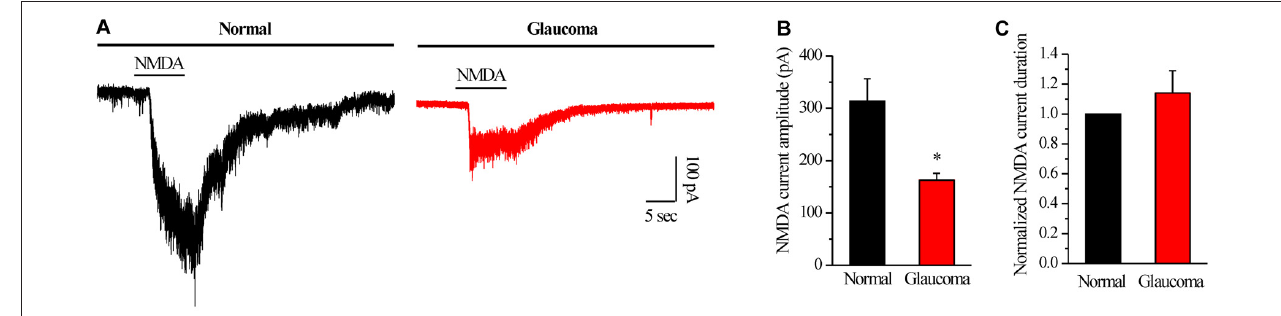
FIGURE 5 | N-methyl-D-aspartate (NMDA)-elicited whole-cell currents in RGCs of the normal and glaucomatous rat retina slice. (A) The membrane current responses elicited by NMDA (100 µ M) from normal and glaucomatous RGCs. (B) Bar graph illustrating the significant differences in the peak amplitudes of the responses recorded from normal ( n = 5) and glaucomatous ( n = 4) RGCs. (C) Summarized data of the duration of NMDA-evoked currents ( n = 4). ∗ p < 0.05 (Student’s paired t test). Holding potential was − 70 mV. Vertical calibration bar, 100 pA; horizontal calibration bar, 5 s. The results are expressed as the mean ± standard